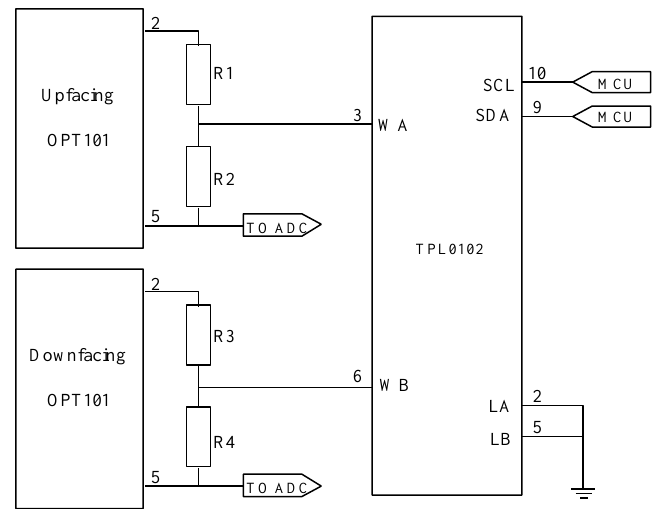
Figure 8. Diagram of the OPT101 gain adjustment circuit.